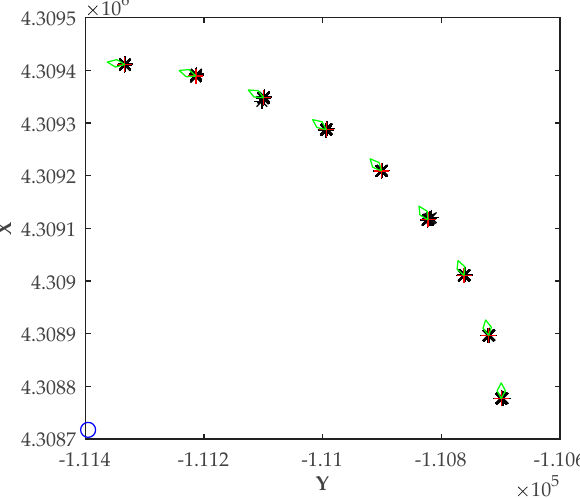
Figure 6. Positioning results with unchanged relative position.